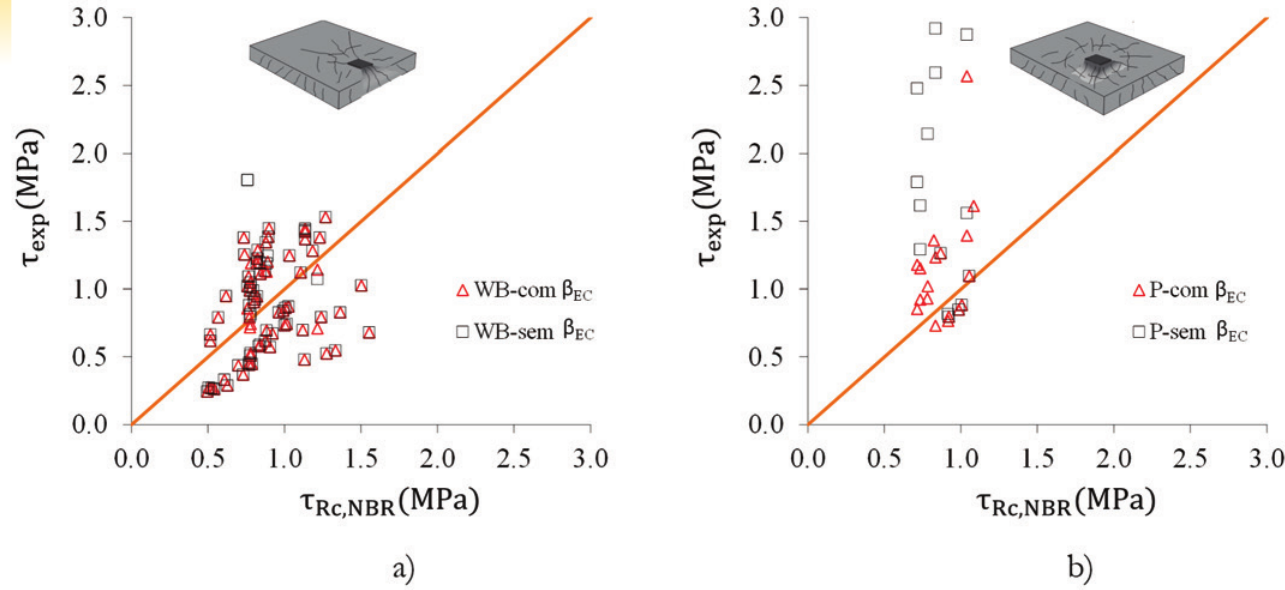
Figure 14 Evaluation of the punching model of ABNT NBR 6118: 2014 according to failure mode in the experiment ( γ = 1): a) Wide Beams, b) c